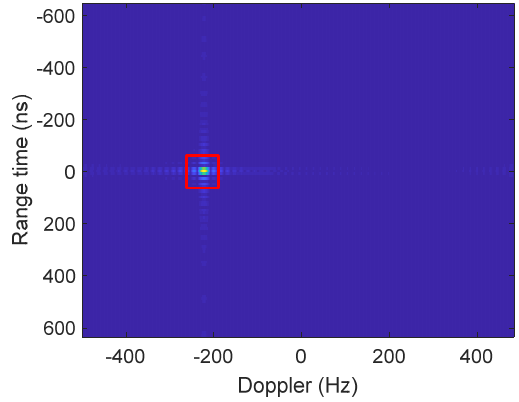
Figure 8. The result after the azimuth compression.